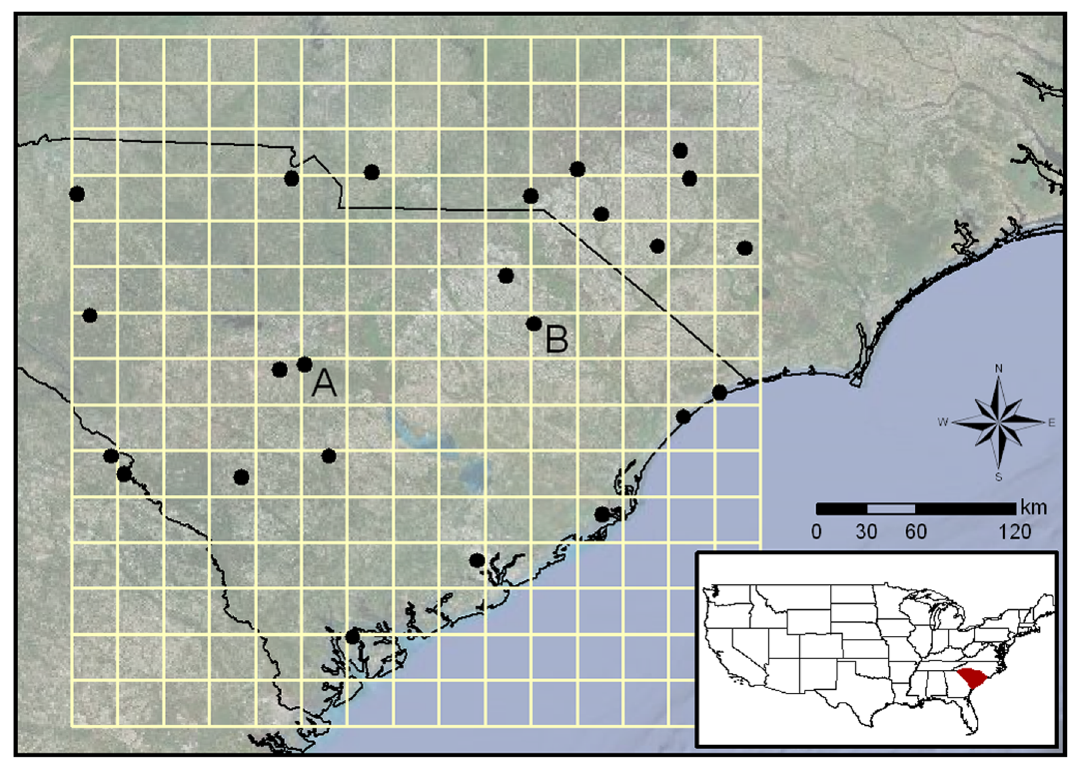
Figure 1. Study area, TRMM satellite pixels and the location of rain